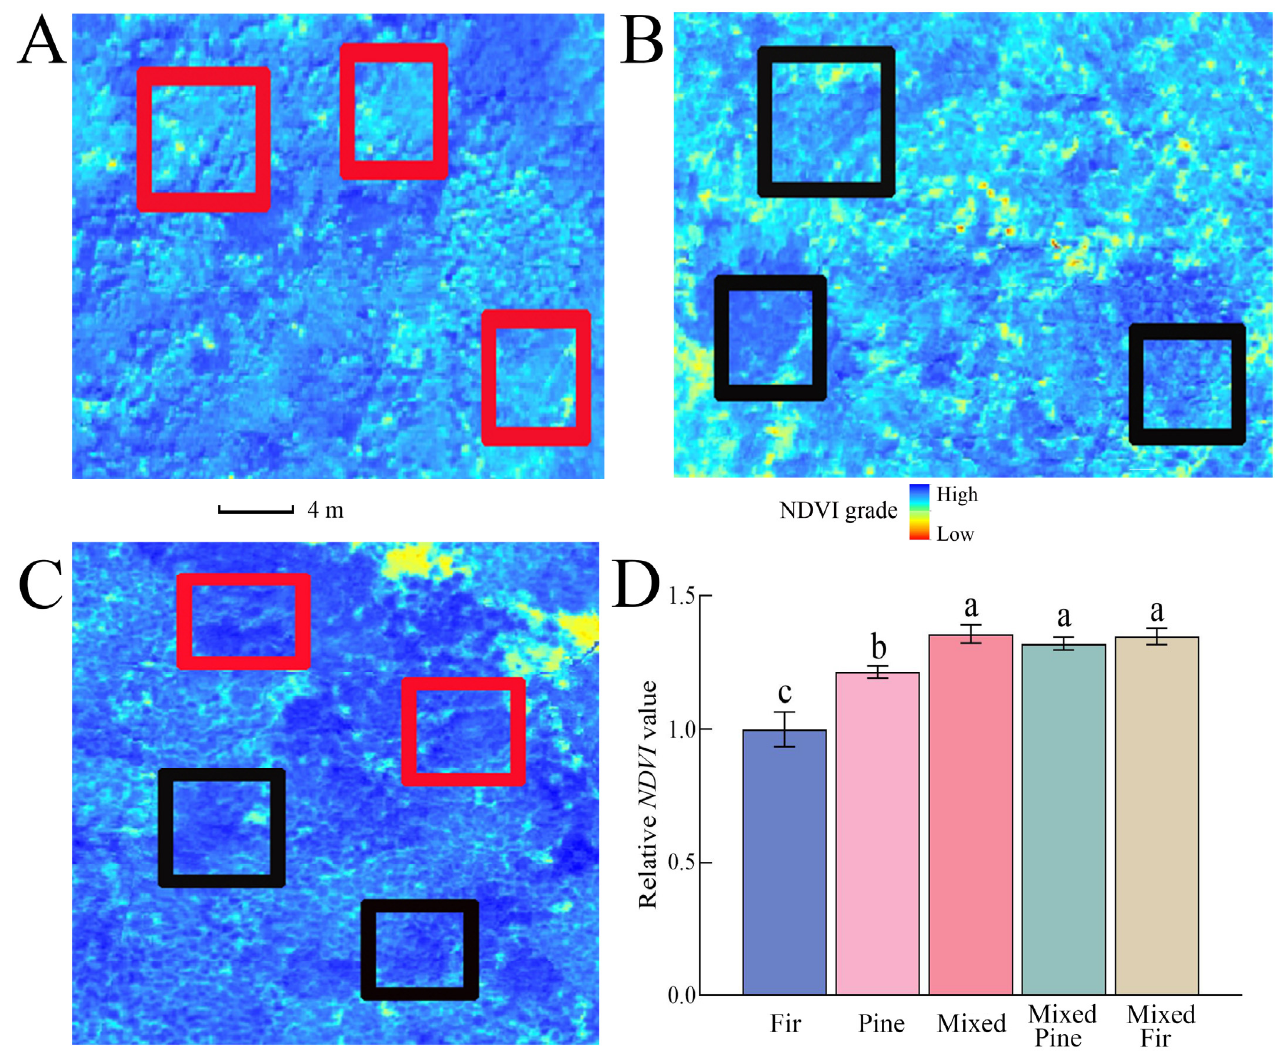
Figure 2. Experimental plots and vegetation indexes of pure forest and mixed forest, ( A ): Fir, pure C. lanceolata forest; ( B ): Pine, pure Pinus forest; ( C ): Mixed, mixed forest of C. lanceolata and Pinus ; ( D ): relative normalized difference vegetation index (NDVI) value; the NDVI values are mean values of these selected rectangles, different letters (a–c) indicate significant differences at the 0.05 level; Mied Fir: C. lanceolata in Mixed; Mixed Pine: Pinus in Mixed. The red rectangles denote Chinese fir and the black rectangles denote Pinus.